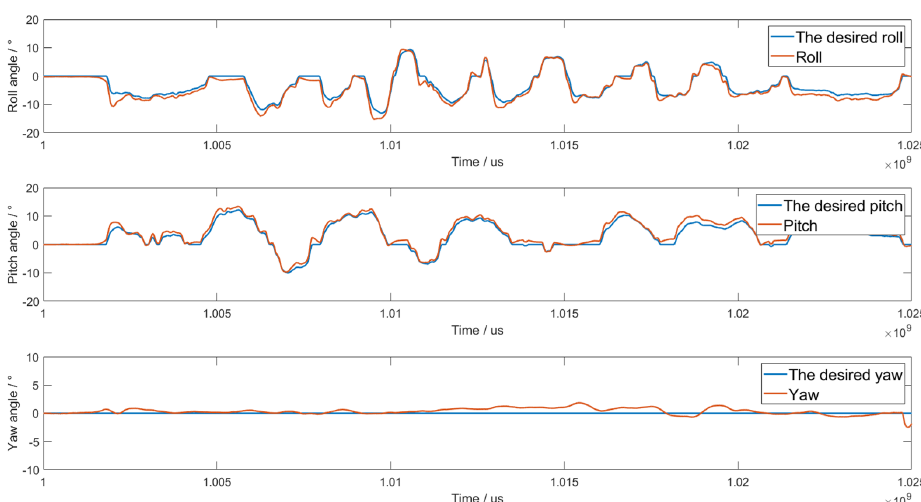
Figure 16. Attitude tracking errors without water in the tank.